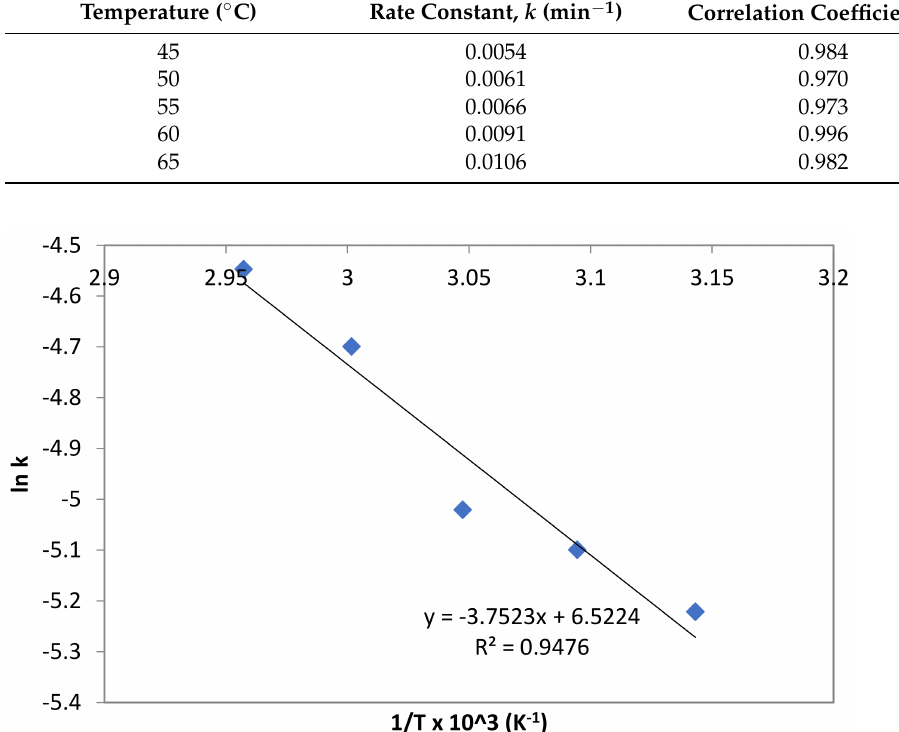
Figure 8. Arrhenius plot of ln k versus 1/ T × 10 3